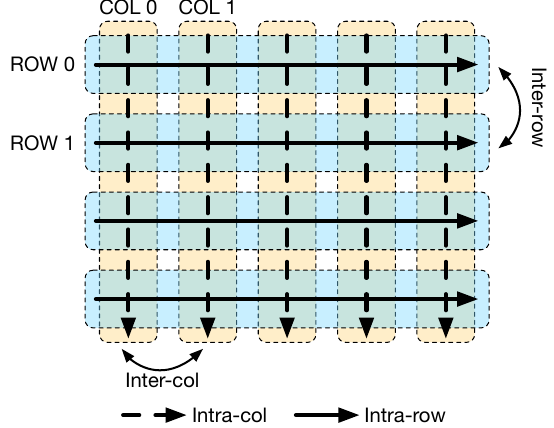
Figure 4. Possible types of data computation inside CLiM